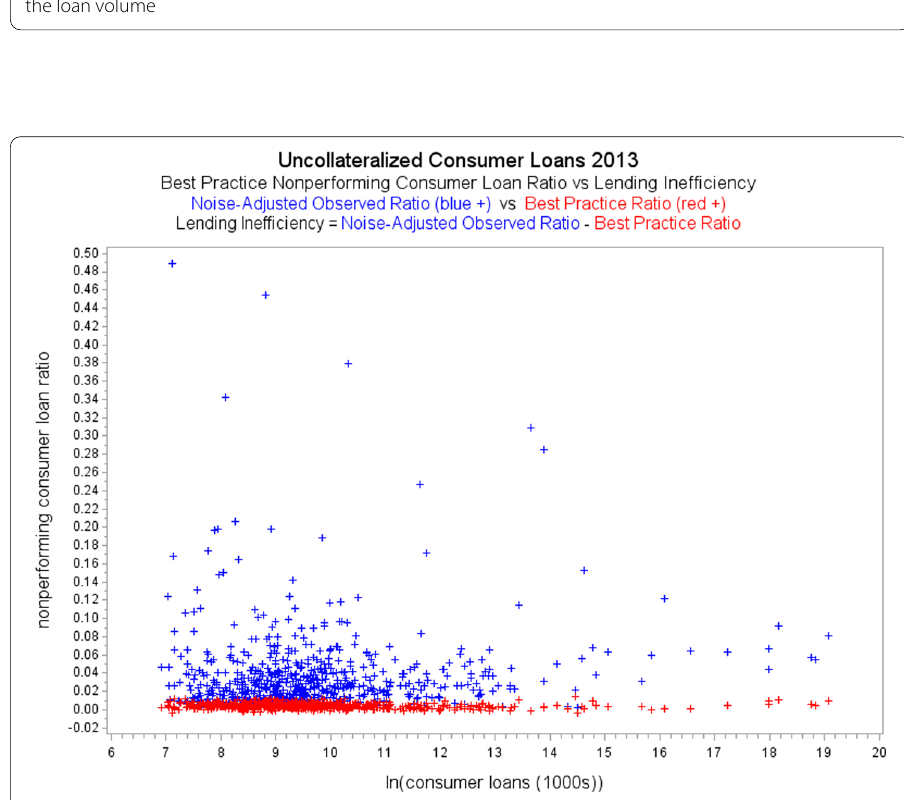
Fig. 6 Nonperforming consumer loan ratio, best practice ratio, and lending inefficiency: 2013, not controlling for the loan